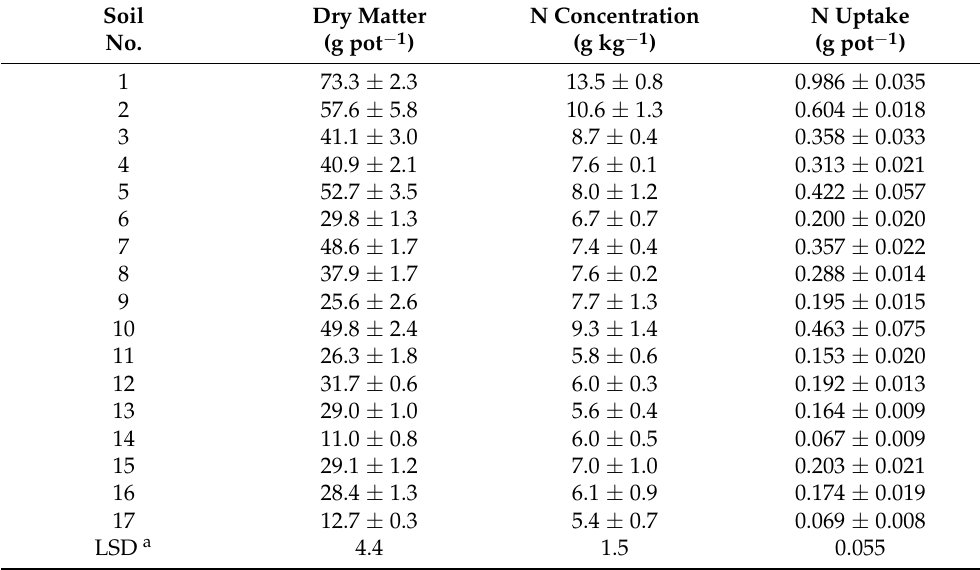
Table 5. Dry matter yield, N concentration, and N uptake after growing maize in a 38 d greenhouse experiment using the soils studied. Data reported for shoots only, as a mean ± standard deviation (4